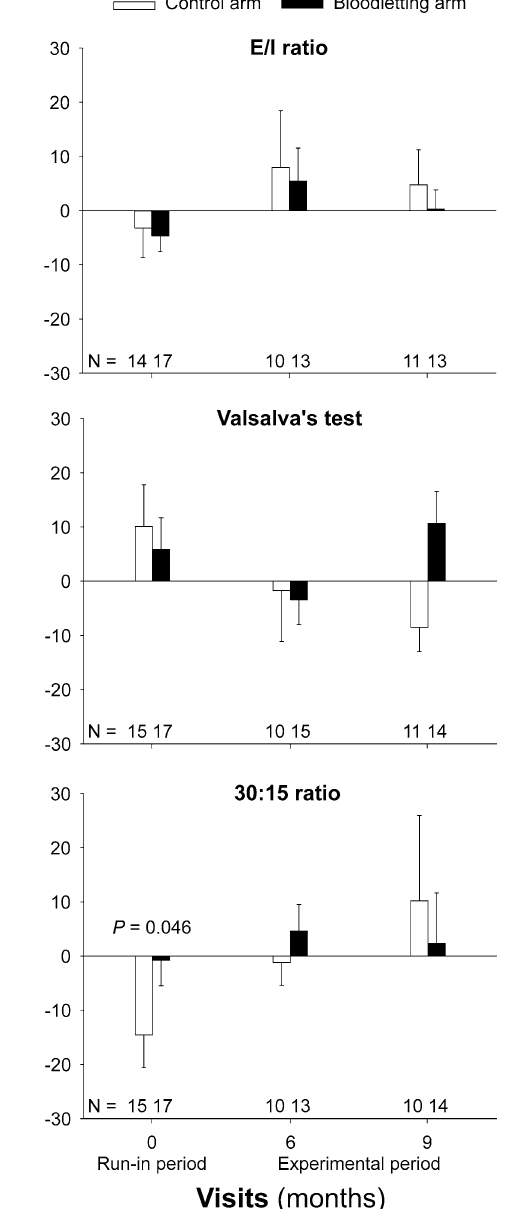
Figure 4. Percentage changes in the Ewing’s cardioautonomic function tests throughout the trial. Data are shown as means (SEM) of the patients remaining at each visit of the trial (figures above the x-axis) even though we conducted intention-to-treat analyses. Left side columns show the changes occurred during the run-in period (from months − 3 to 0). Central columns show the percentage change occurred from months 0 to 6 of the experimental period. Right side columns show the percentage change observed from months 0 to 9 of the experimental